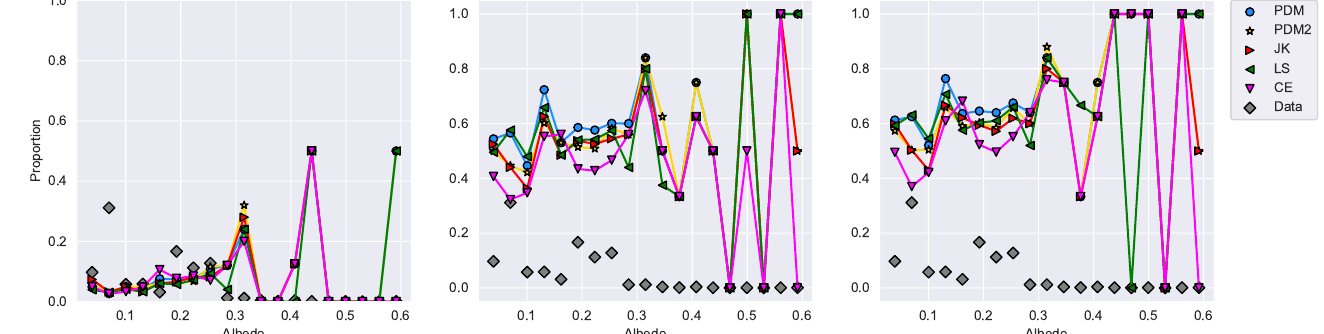
Figure 8. The comparison of different period finding algorithms considering the different albedos for the step size defined in Equation (3) with A = 10. The criterion for comparison is the proportion of asteroids having a successful periodic recovery. From left to right, the three plots are for different δφ max = 85/50,850/50 and 8500/50. The gray diamonds indicate the proportion of asteroids at the corresponding albedo in our data set.